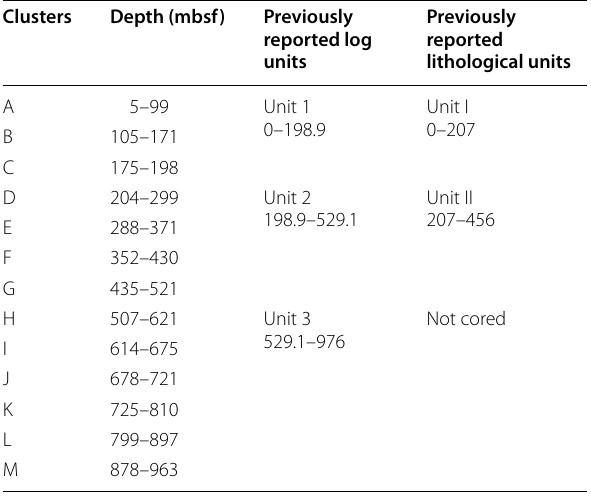
Table 1 Clustering results for Site